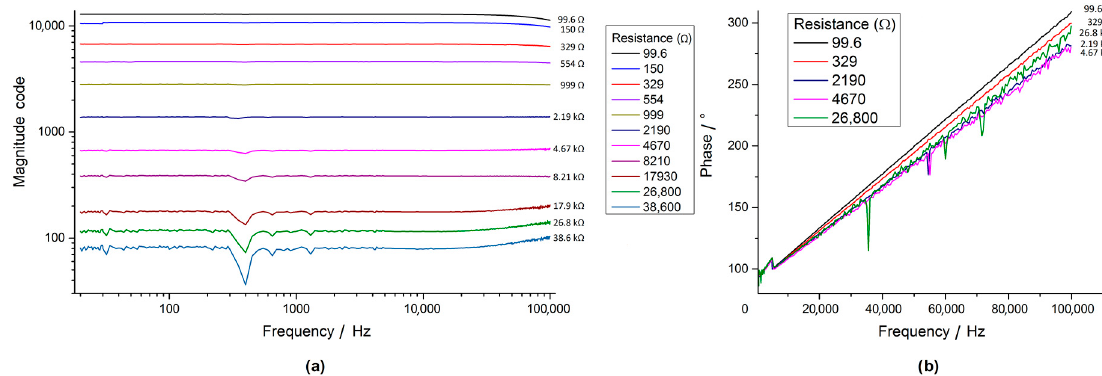
Figure 20. Characteristic curves of the AD5933 impedance converter setup for a selection of resistor values for ( a ) the magnitude code and ( b ) the measured system phase versus frequency. The graph in ( a ) shows significant resonance behaviour at 300 Hz, however the effect becomes less severe at lower resistance values.